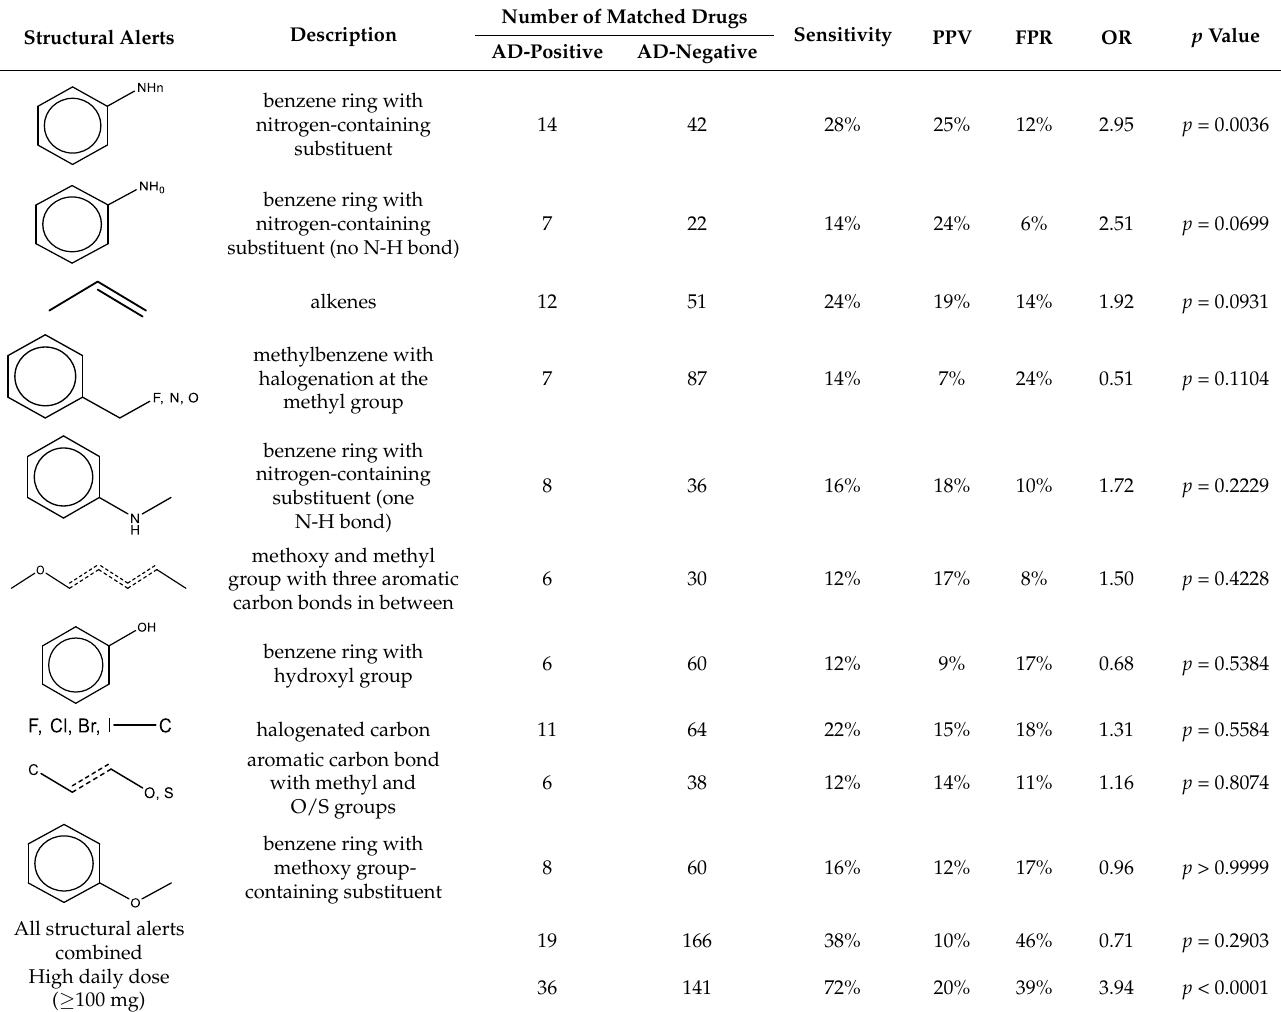
Table 1. Ten structural alerts most frequently contained in the chemical structures of autoimmune disease (AD)-positive drugs. Structural Alerts